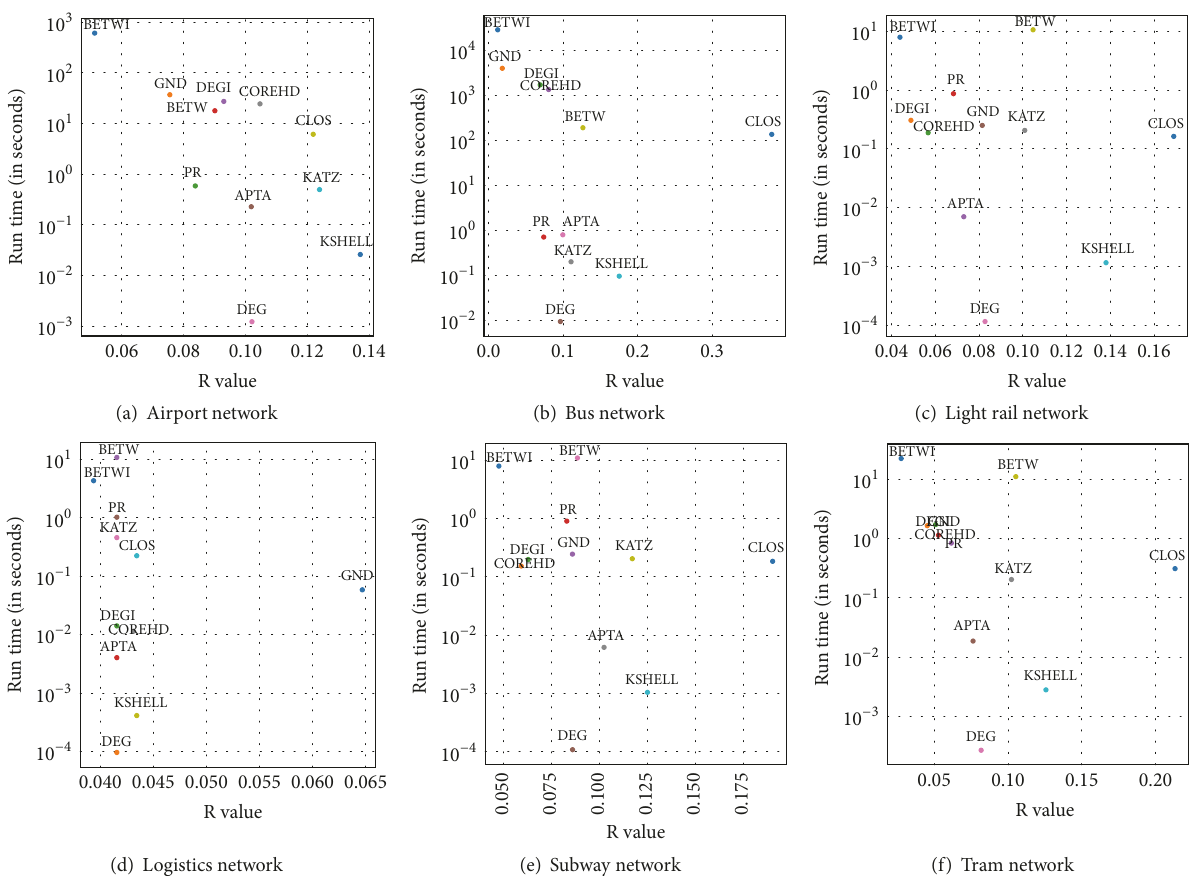
Figure 6: Comparison of attack heuristics regarding R value (x-axis) and Run time (y-axis) on six transportation networks, as described in